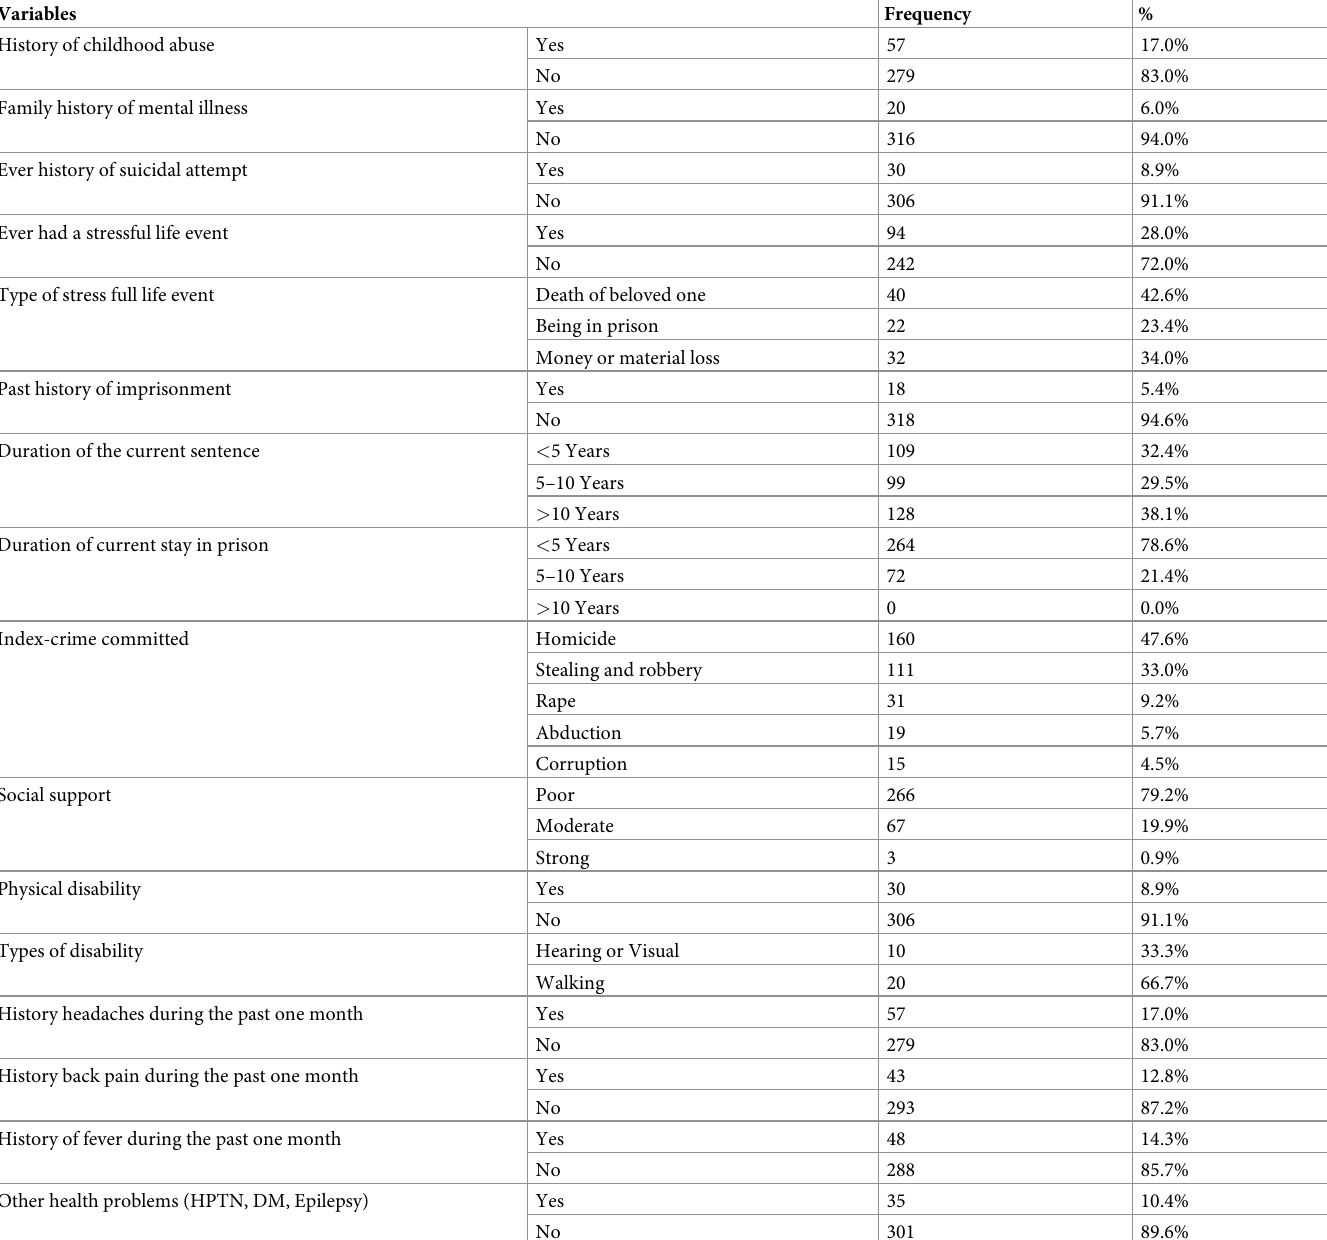
Table 2. Psycho-social, imprisonment and physical status of inmates of Debre Berhan prison, Ethiopia, 2015.